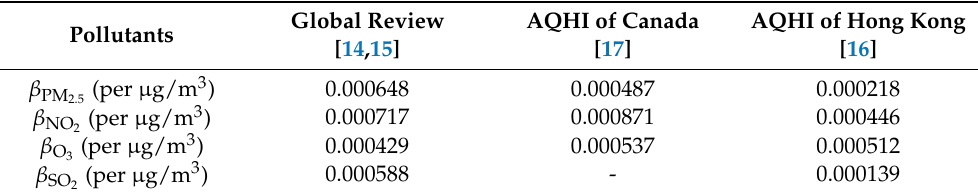
Table 1. β coefficients of PM 2.5 , NO 2 , O 3 , and SO 2